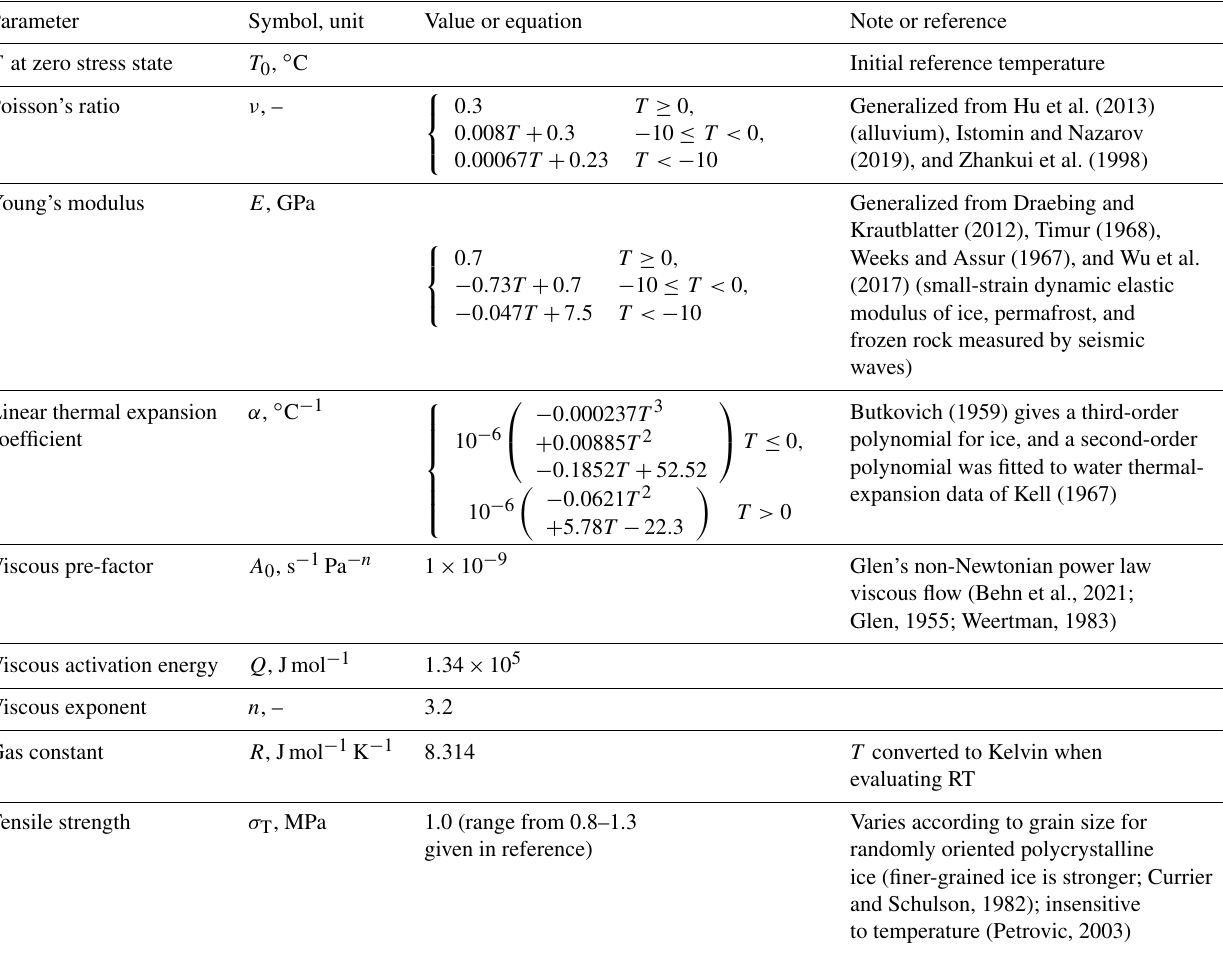
Table 1. Physical parameters used in the thermal-stress model. Parameter Symbol,